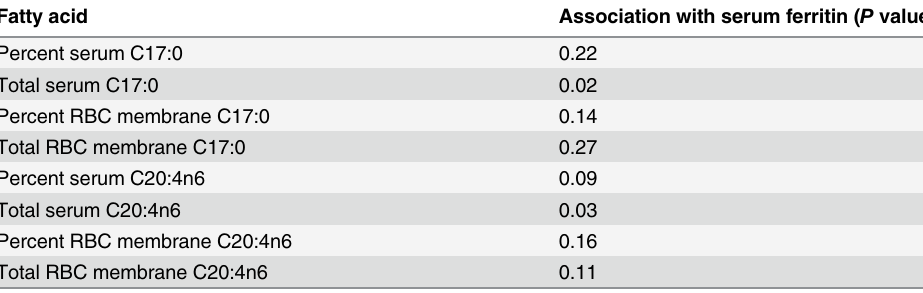
Table 5. Tested linear associations between C17:0 and C20:4n6 with ferritin in Sarasota Bay dolphins (n = 19) using a general linear